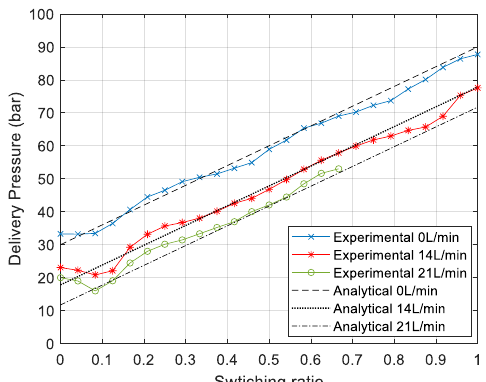
Figure 4. Experiment and analytical delivery pressure (delivery flow = 0, 14, and 21 L/min; switching frequency = 200 Hz; switching ratio from 0 to 1; overall resistance = 0.87 bar/(L/min)).